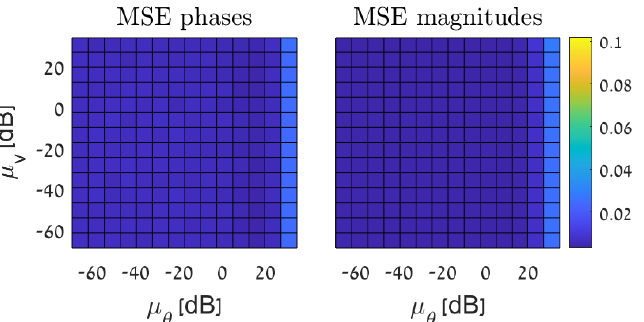
Figure 11. State estimation based on the AC − PF model: the MSE of the GSP − WLS (Algorithm 2) for phase estimation ( left ) and magnitude estimation ( right ) with q = 48 buses and σ 2 = 0.01 versus the value of the tuning parameters, µ θ and µ v